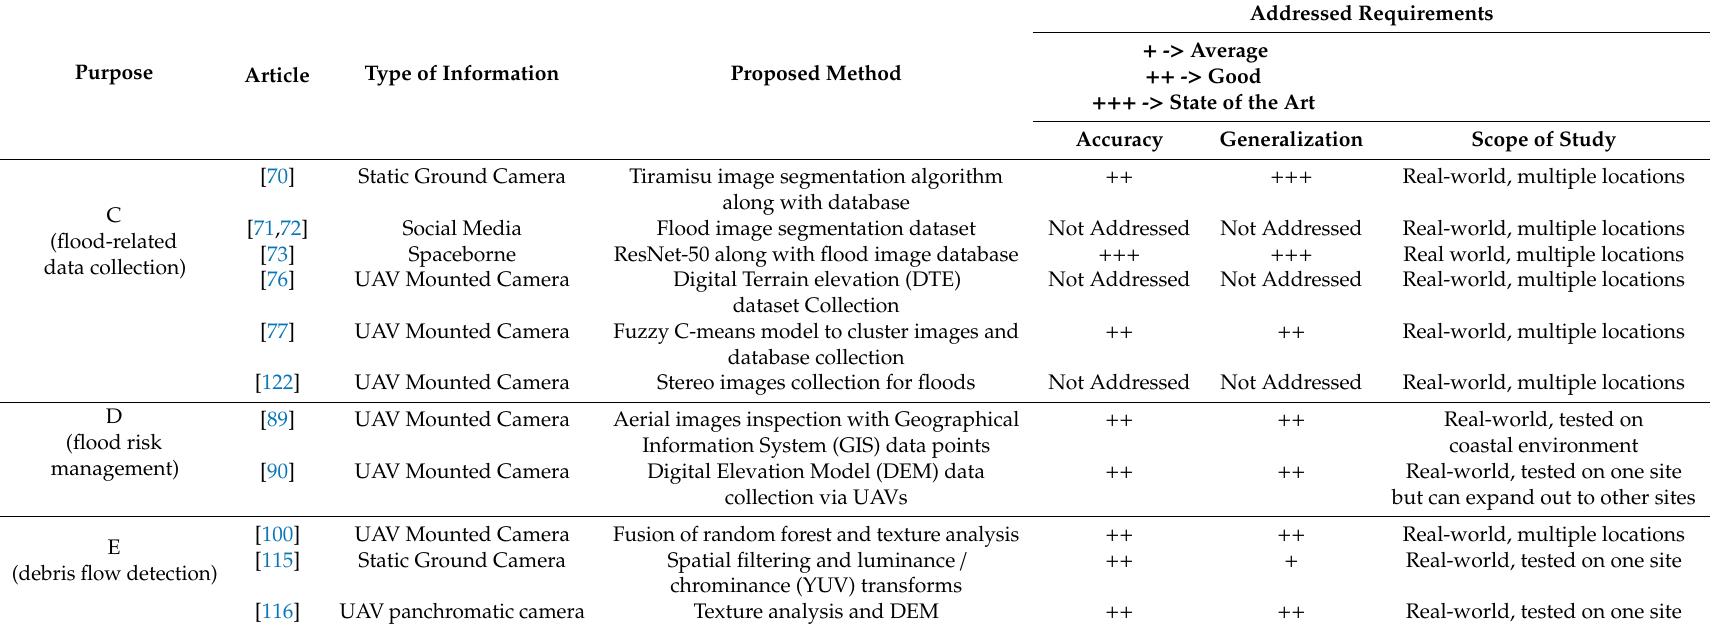
Table 8. Analysis of computer vision applications against addressed requirements: Part